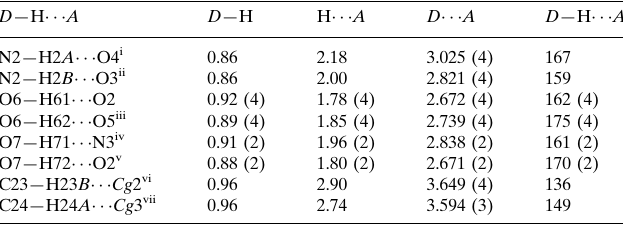
Hydrogen-bond geometry (A˚ , (cid:3)